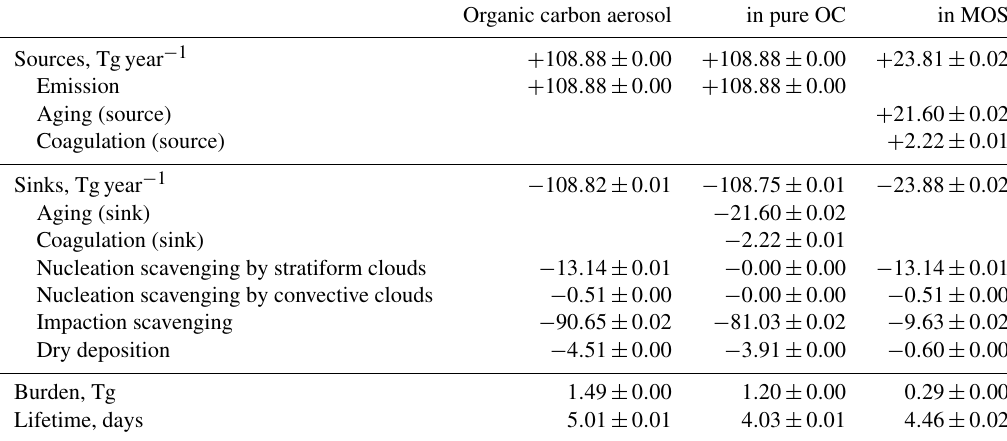
Table 2. Global mass budgets and lifetimes of organic carbon aerosol for the year-2000 MARC simulation, showing values for total organic carbon aerosol and organic carbon aerosol in each mode. The processes acting as sources and sinks are summarised in Fig. 1b. Emissions include volatile organic compounds converted to organic carbon aerosol. Aging and coagulation transfer organic carbon between modes, but do not directly influence the total organic carbon aerosol mass. Corresponding results for the year-1850 MARC simulation are shown in Table S2. Organic carbon aerosol in pure OC in MOS Sources, Tgyear −